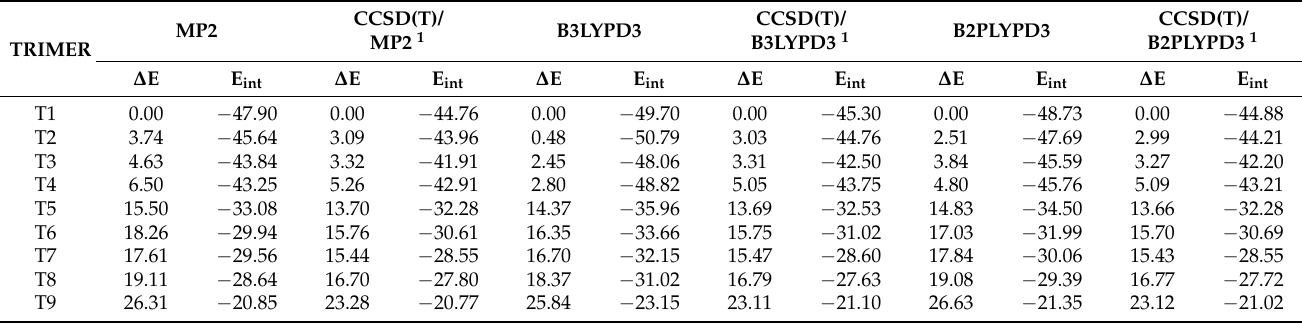
Table 3. BSSE-corrected interaction energies E int and relative energies ∆ E (kJ mol − 1 ) of the HNCO trimers calculated at MP2, B3LYPD3, B2PLYPD3 and CCSD(T) levels with 6-311++G(3df,3pd) basis